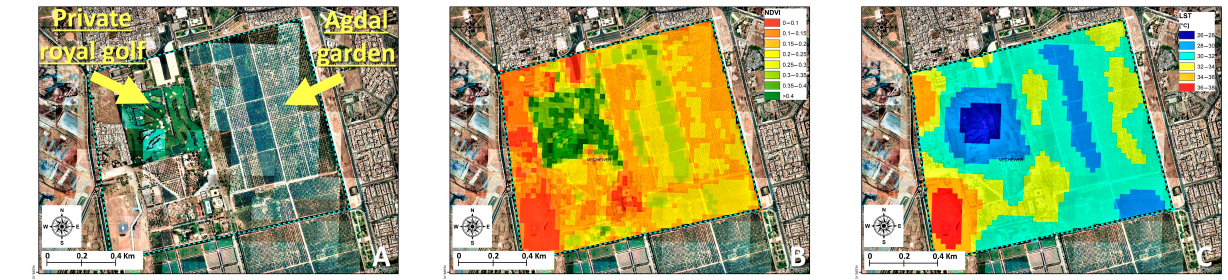
Figure 11. The satellite image ( A ), NDVI ( B ) and LST ( C ) of the Agdal Garden and the royal private golf course.